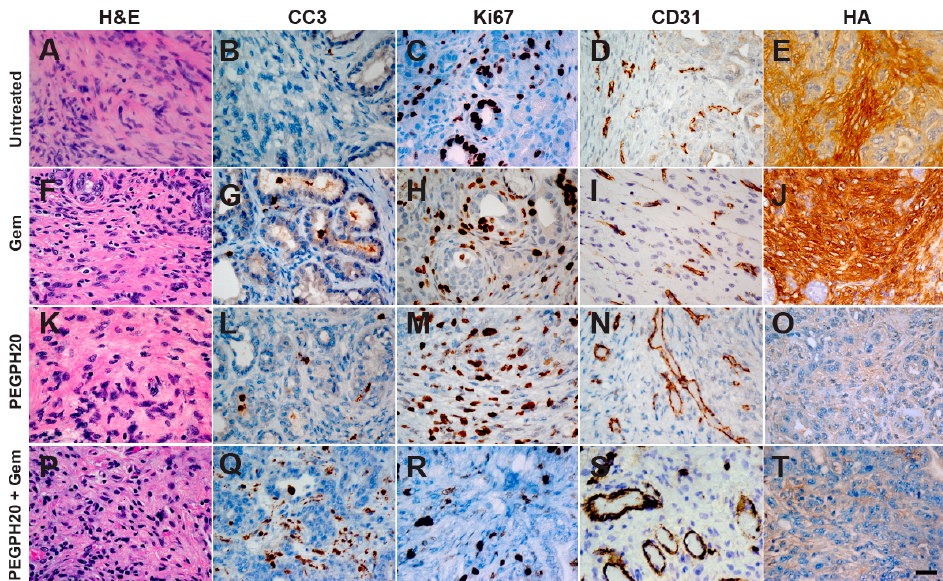
Figure 3. Representative histochemistry of PDA from untreated and treated with gemcitabine (Gem), PEGPH20, or PEGPH20 + gemcitabine KPC mice. Untreated KPC tumors ( A – E ) and gemcitabine administered as a monotherapy ( F – J ) show low levels of apoptosis (CC3), increased proliferation (Ki-67), collapsed vasculature (CD31), and high levels of hyaluronan (HA). When treated with PEGPH20, HA is